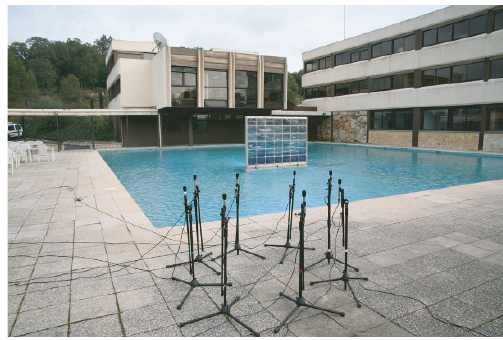
Figure 14: Microphone setup used to record the fountain example. In this case, the microphones are placed at the center of the action.